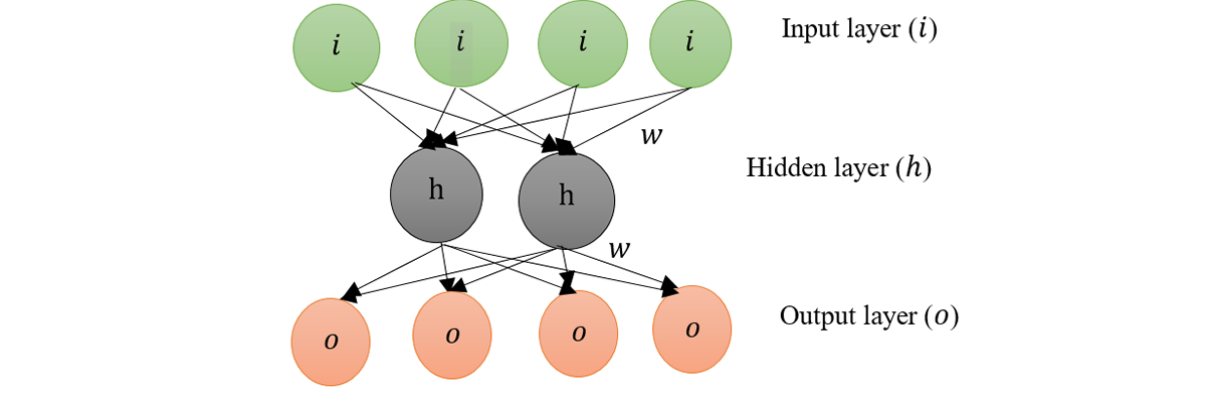
Figure 5. Structure of a simple autoencoder showing input, hidden, and output layers. The interconnection between the neurons is shown in the direction of the